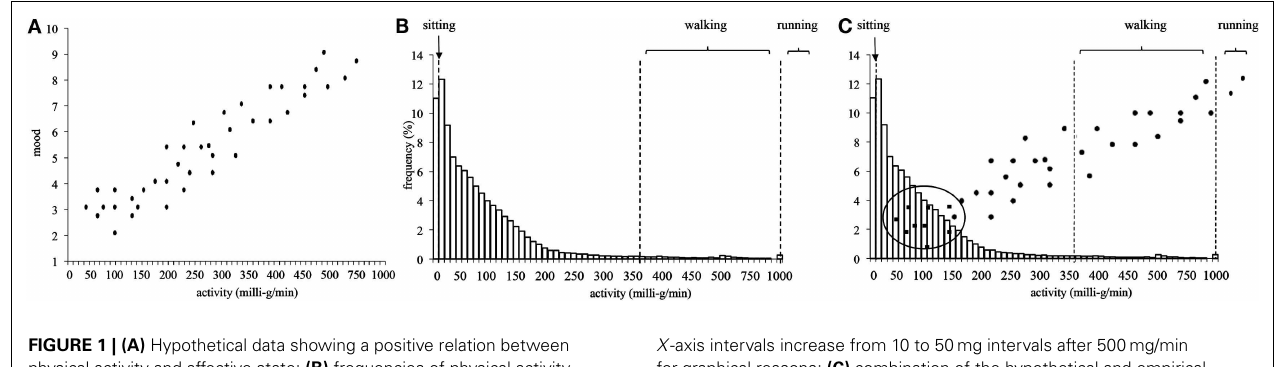
FIGURE 1 | (A) Hypothetical data showing a positive relation between physical activity and affective state; (B) frequencies of physical activity (70 students, 24h) aggregated over 10-min episodes. Please note: